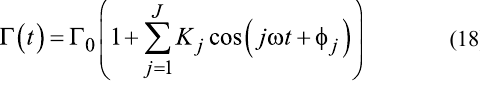
Figure 10: Signal-to-noise ratio (red points) as measured for different outcoupling positions alongside the atomic response function (blue